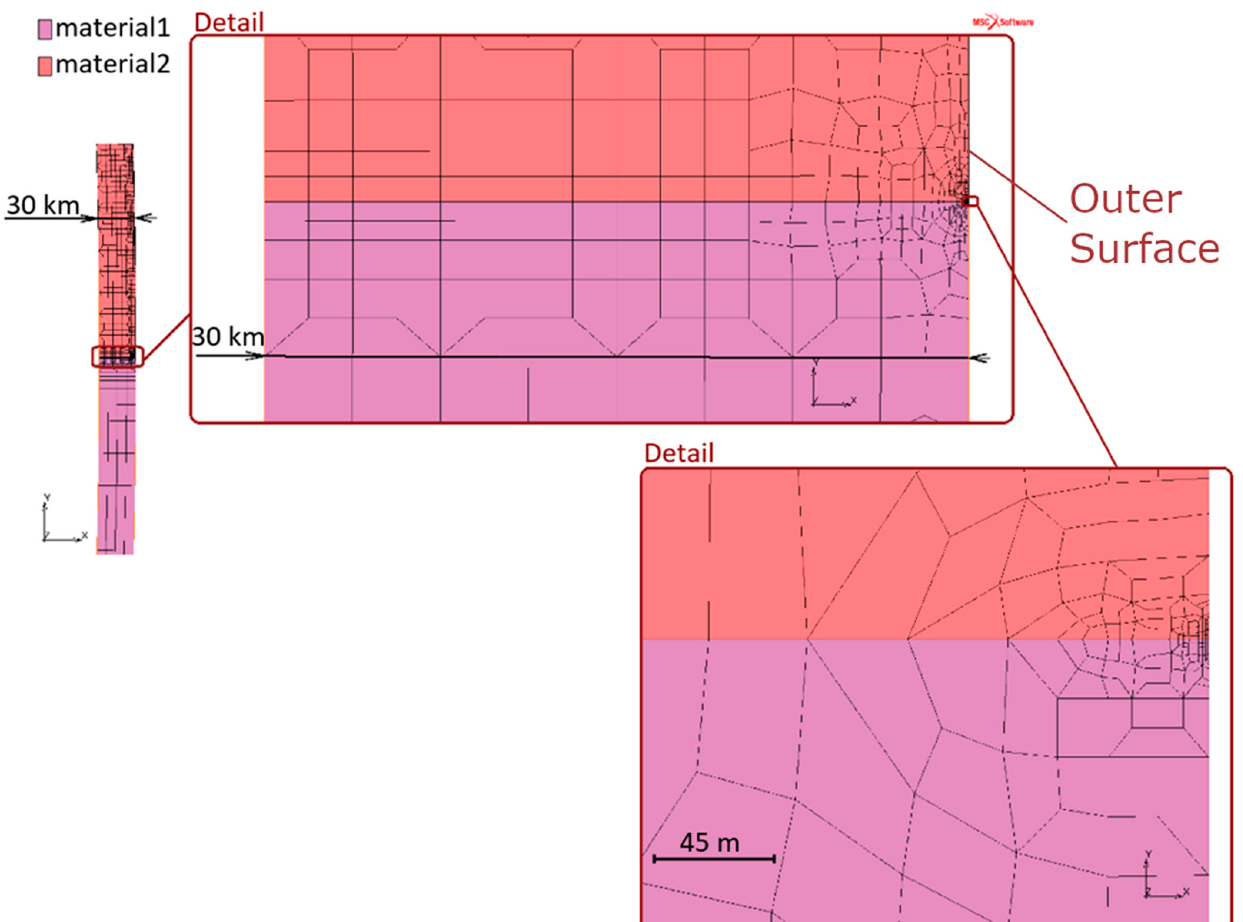
Figure 7. Detail of biased mesh (re fi nement towards the surface of the Earth).